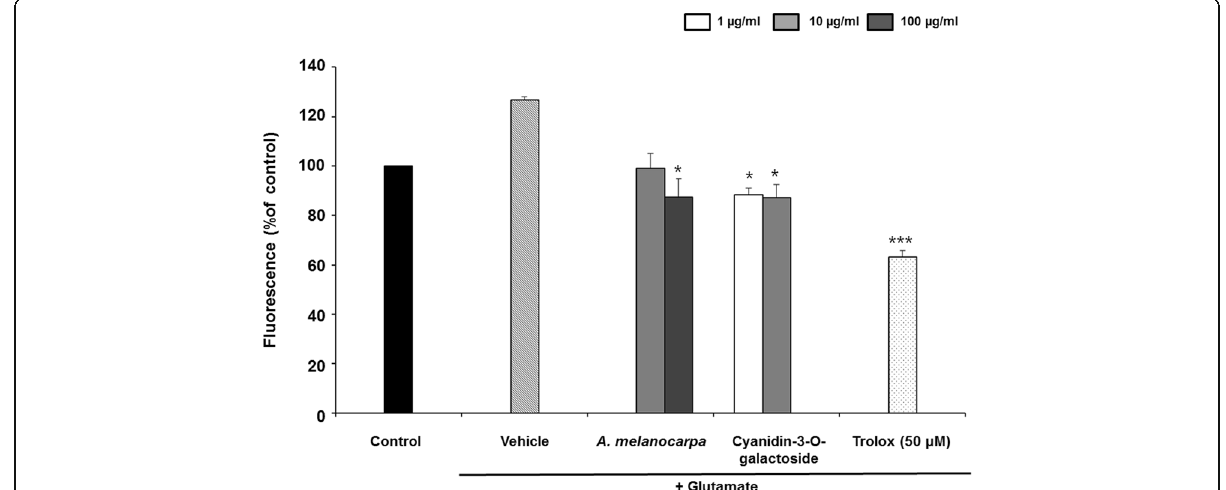
Fig. 2 Effect of A. melanocarpa extract (10 and 100 μ g/ml) and cyanidin-3-O-galactoside (1 and 10 μ g/ml) on ROS production in HT22 cells. Data are means ± S.D. * p < 0.05 versus the glutamate-treated